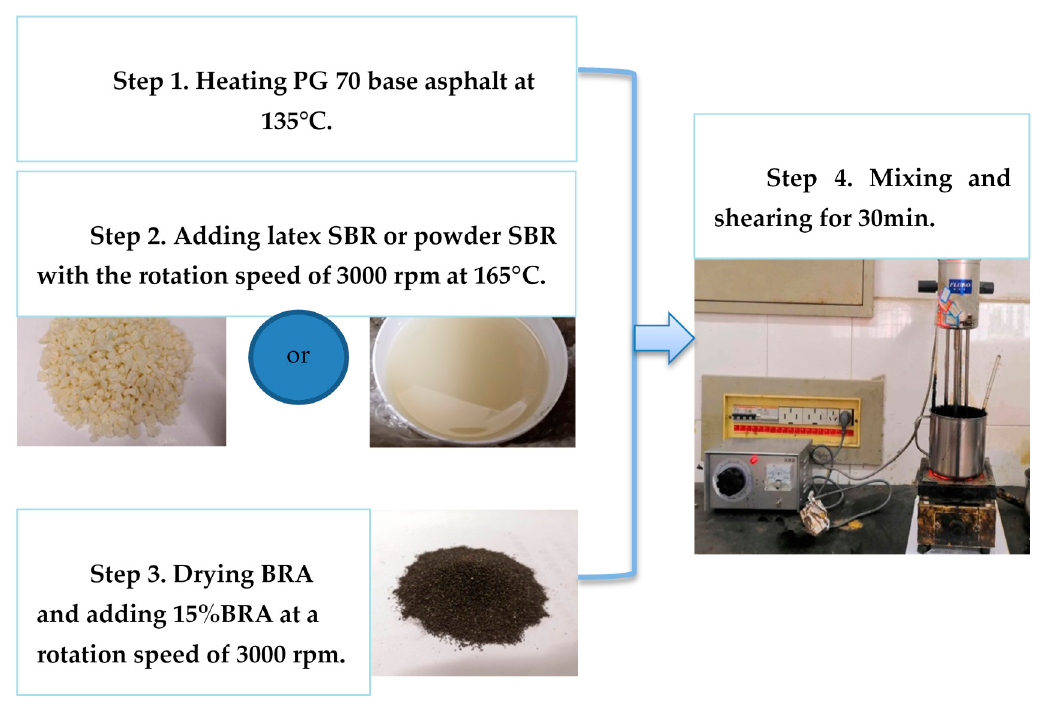
Figure 1. Production process of BRA-SBR compound modified asphalt 3. Test methods.